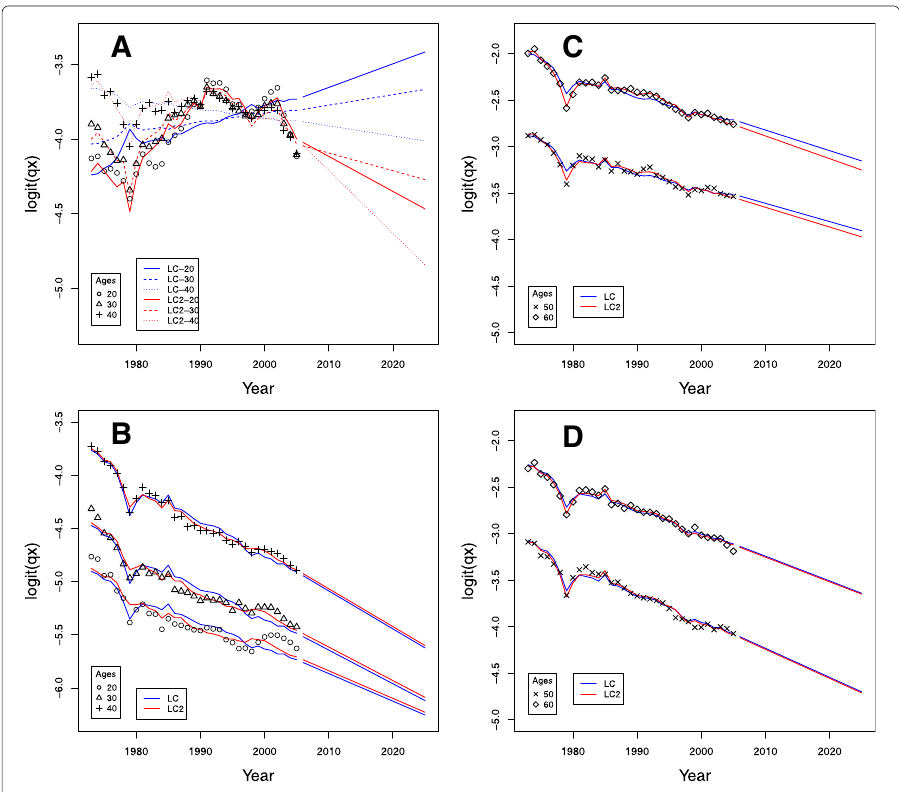
Fig. 9 Death probabilities between 1973 and 2005 and predictions up to 2025 for some ages, Colombia. a Ages 20–40 years, men. b Ages 20–40 years, women. c Ages 50–60 years, men. d Ages 50–60 years, women